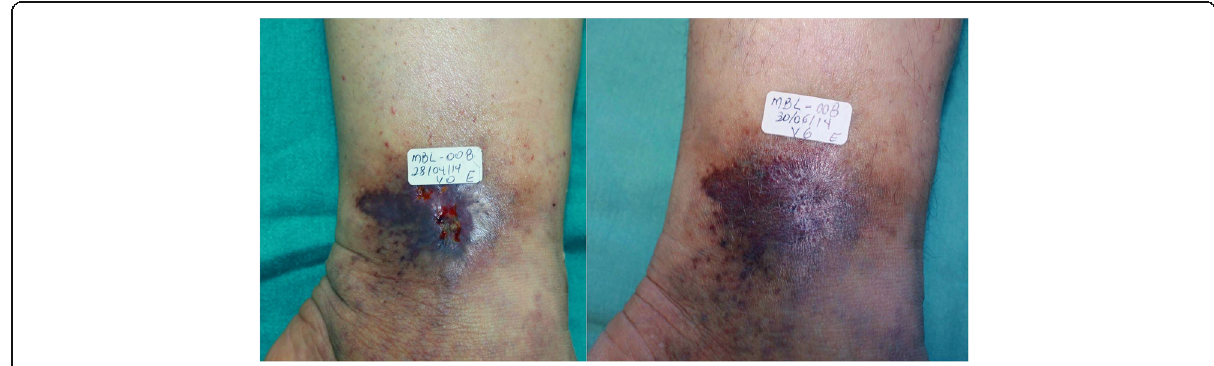
Fig. 14 The 50 year-old patient had an ulcer for 4 months. a Visit 0 – area of the ulcer was 0.3 cm 2 . b Visit 6 – wound